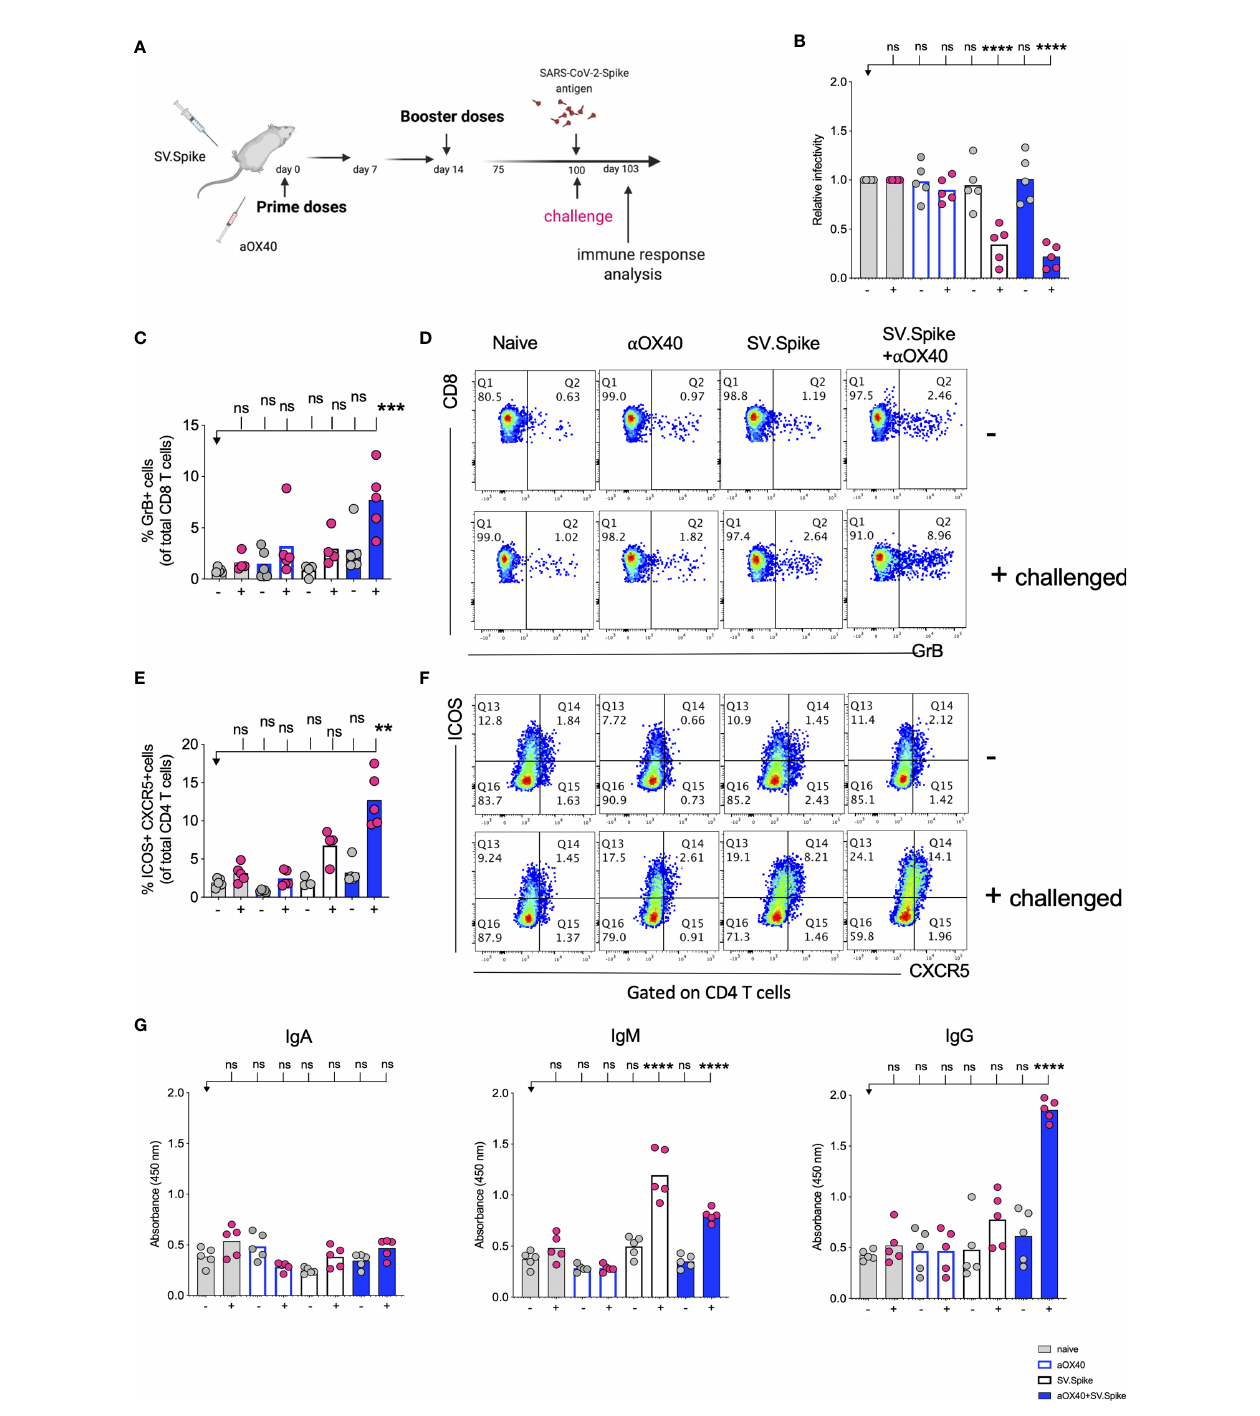
FIGURE 11 | Challenging immunized mice with spike antigen promotes a fast and coordinated response of the two arms of the adaptive immune system. Humoral and T cell immune responses were assessed in vaccinated mice after “ challenge ” with Sindbis carrying SARS-CoV-2-spike (SV.Spike). (A) Design steps of the “ challenge ” experiment in immunized C57BL/6J mice evaluated by (B) T cell cytotoxic assay, (C – F) Flow cytometry indicating cytotoxic CD8 T cell effector response by GrB+ positive CD8 T cells and activation of CXCR5+ICOS+ positive Tfh cells upon “ challenge ” , (G) binding IgA, IgM, IgG antibody ELISA to SARS-CoV-2-spike recombinant protein (n=5 mice per group, or as otherwise indicated). Each symbol represents one individual mouse. Bars or symbols represent means ± SEM, and statistical signi fi cance was determined with one-way ANOVA with the Bonferroni correction (B, G) or with the Kruskal-Wallis test followed by Dunns ’ test (C – F) . n.s. > 0.05, **p<0.005, ***p ≤ 0.001, ****p ≤